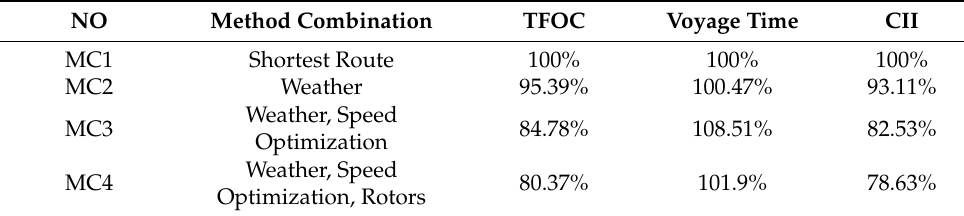
Table 3. Averaged routing results for 30 cases per method